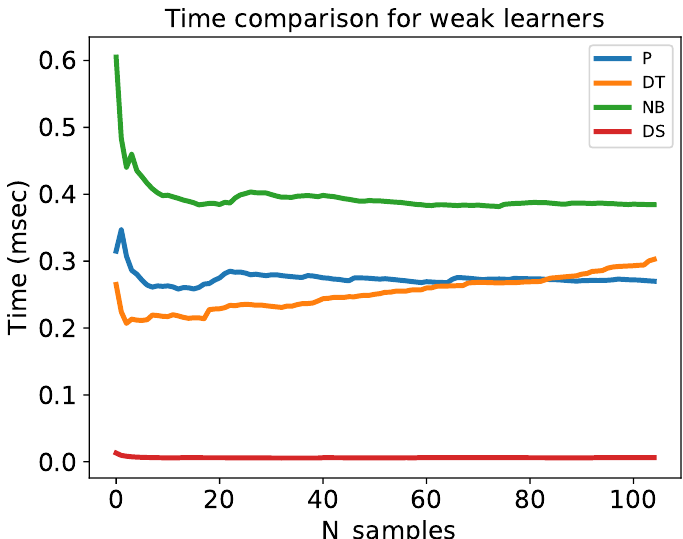
Figure 5. Comparison of computational time for the weak